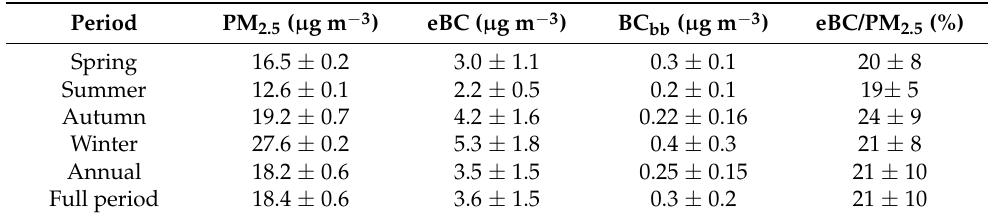
Table 1. Mean concentrations of PM 2.5, equivalent black carbon, black carbon related to biomass (BC BB ) in µ g m − 3 with standard deviation, and relative contribution of eBC to PM 2.5 in % for the season, year and full sampling period.